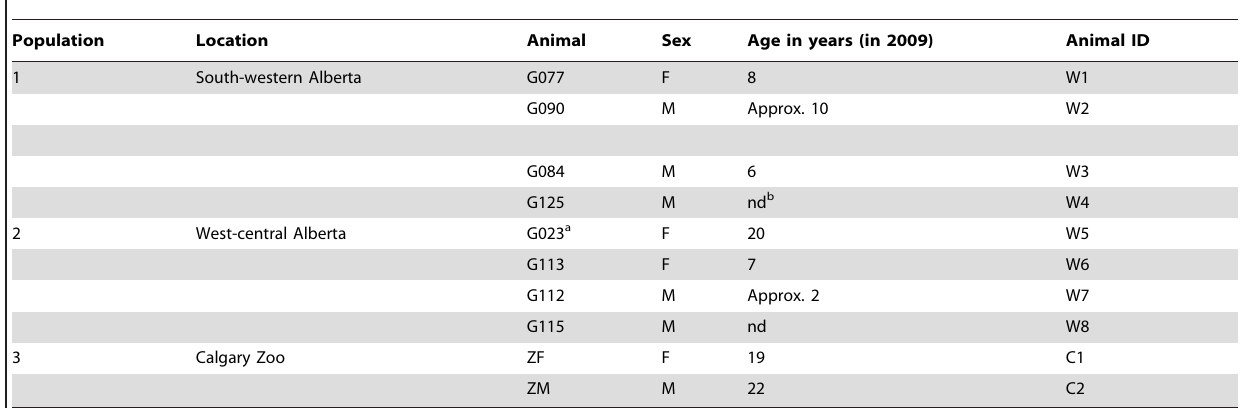
Population Location Animal Sex Age in years (in 2009) Animal